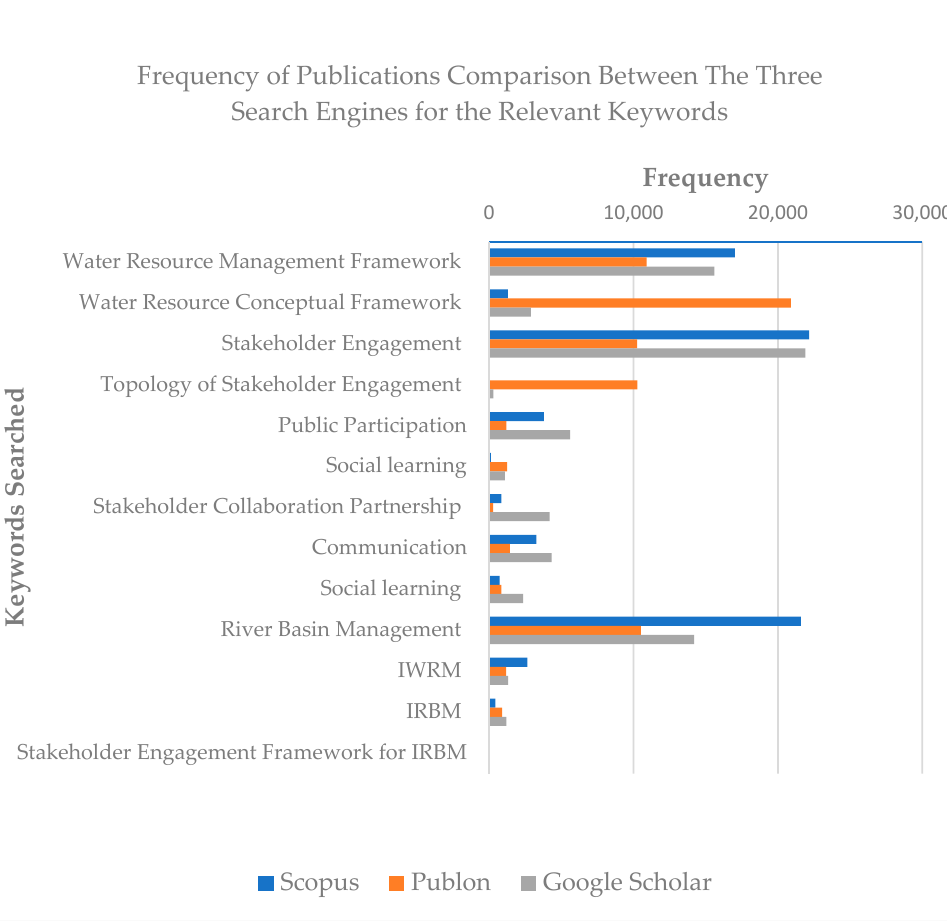
Figure 3. Comparison of the frequency of publications found for each keyword on the three scientific databases.